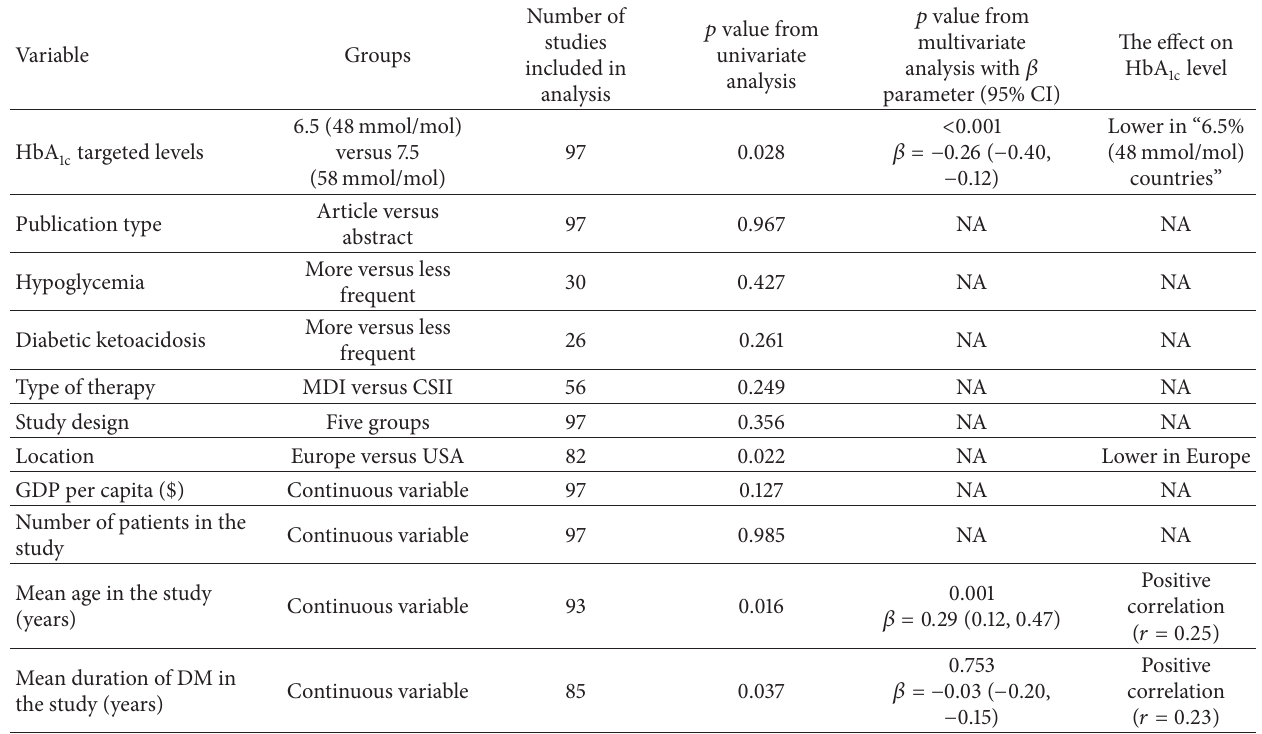
Table 1: Univariate and multivariate linear model results for HbA covariates. NA means not